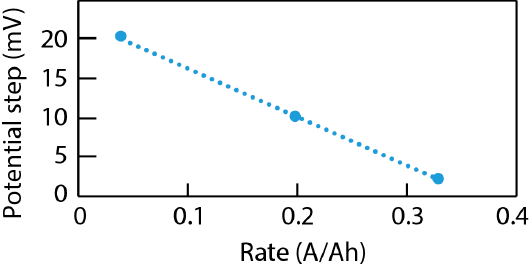
Figure 8. Voltage step chosen for charge ICA analysis as a function of the charge rate.